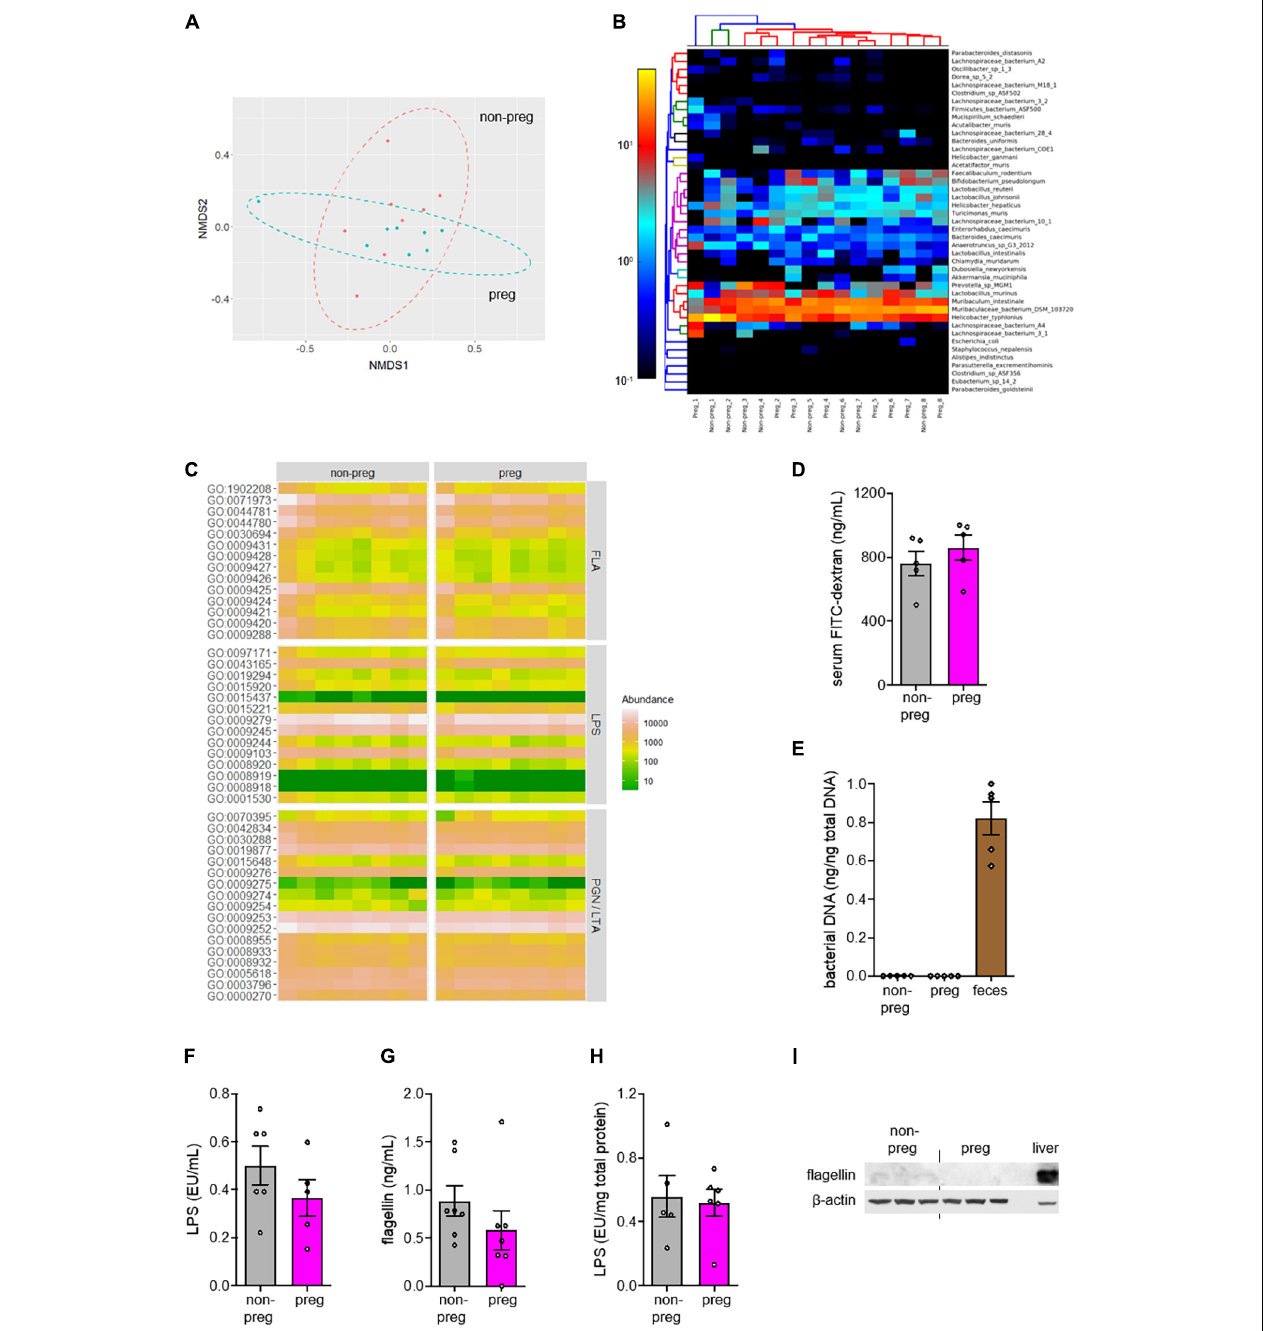
FIGURE 2 | No change in β -diversity or functional pathways related to TLR ligands in gut microbiota was observed during pregnancy. (A–C) Feces were collected from wild type non-pregnant (non-preg) and pregnant (preg) mice at embryonic day 9.5 and the isolated DNA was subjected to shotgun metagenomic sequencing ( n = 8 mice). (A) The non-metric multi-dimensional scaling (NMDS) plot of species-level relative abundances using the Bray-Curtis dissimilarity index was shown. (B) The heatmap shows the relative abundance of identifiable bacterial strains present in feces from both groups. The number following the underscore indicates the sample number. The differences in composition between groups were determined by PERMANOVA ( R 2 = 0.0287, P = 0.804, df = 15). (C) The relative abundances of genes involved in biosynthesis of flagellins (FLA), lipopolysaccharides (LPS), peptidoglycans (PGN) and lipoteichoic acids (LTA) were shown. (D) Wild type non-pregnant and pregnant mice were fasted for 6 h and orally gavaged with FITC-conjugated dextran. Gut permeability was assessed by the measurement of fluorescent signals of FITC in serum ( n = 5 mice). (E) Total DNA was isolated from uterus of non-pregnant mice and conceptus from pregnant mice ( n = 5–6 mice). The amount of bacterial DNA was quantified by 16S rRNA gene amplification. Feces was included as positive control. (F–I) The serum levels of (F) LPS and (G) flagellin were measured. The conceptual levels of (H) LPS and (I) flagellin were evaluated with uterus as baseline for the non-pregnant group ( n = 5–7 mice). Liver was included as positive control for flagellin immunoblotting. Representative images are shown. Data are represented as mean ± SEM. The differences between non-pregnant and pregnant groups were determined by two-tailed Student’s t -test. P -values were adjusted for multiple comparison in (C) .